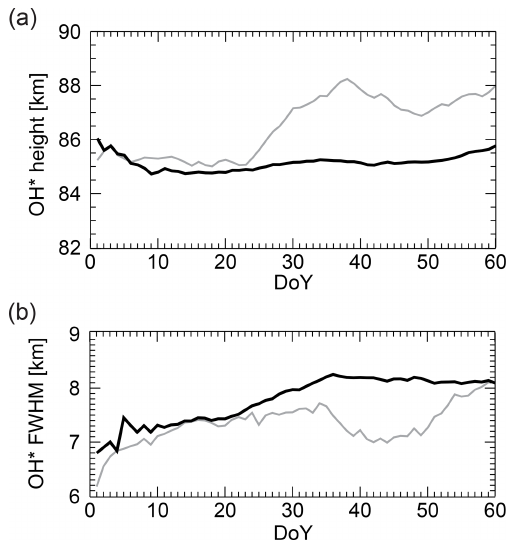
Figure 2. The different curves represent 15d running means of the OH* layer height (a) and its FWHM (b) calculated from TIMED- SABER VER profiles (OH-B channel) within a rectangle centred at ALOMAR with 300km edge length. Shown is the time period DoY 1-60. The black line is the mean of all years, and the grey line the year 2016. If more than one value is available per day, a daily mean is calculated before smoothing. However, it can also happen that no SABER measurement is available for a specific day.